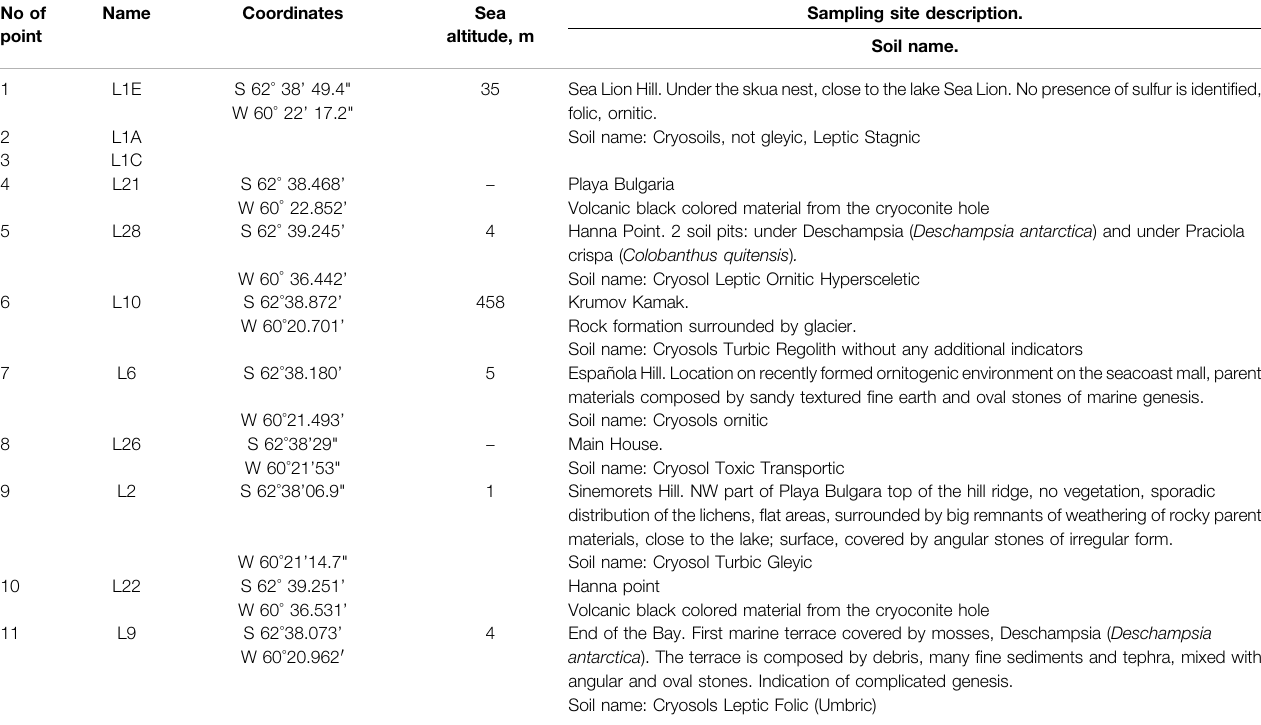
TABLE 1 | Sampling points coordinates, geographic description and soil type of the study area (WRB,